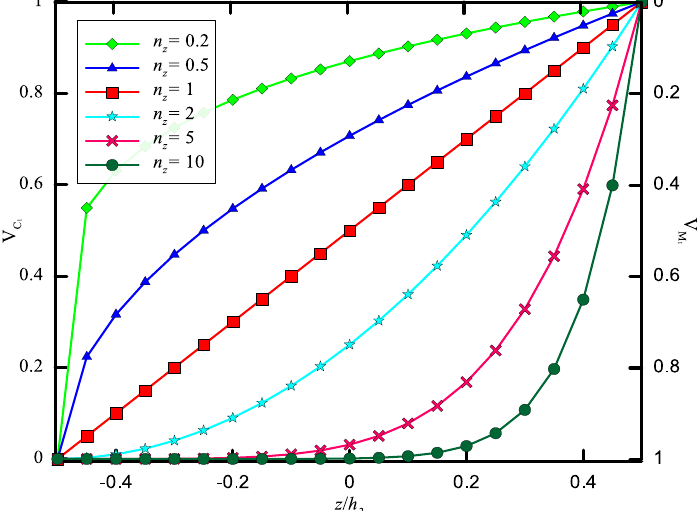
Fig. 2. Through-thickness volume fraction variation of both M 1 and C 1 material constituents for different values of n z and a value of zero for n x .